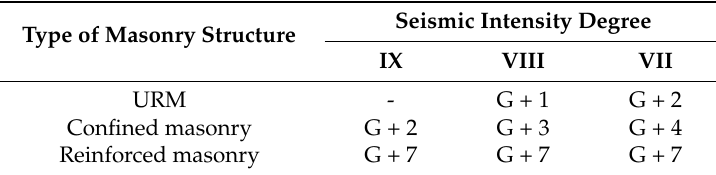
Table 1. Allowed number of storeys for different masonry structures [10].